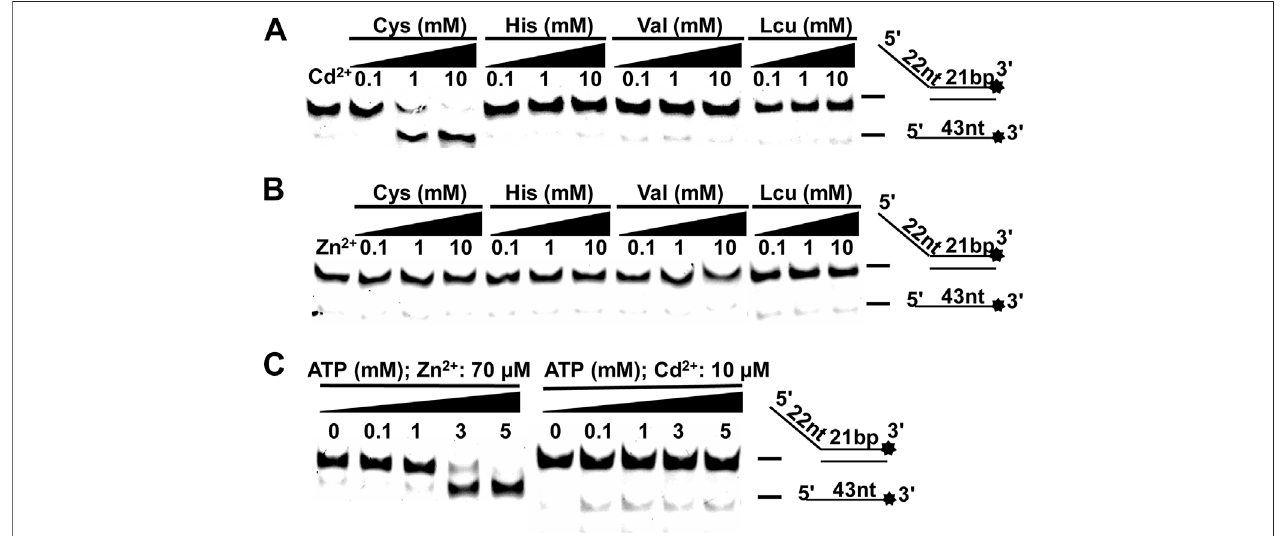
FIGURE6| TheeffectsofaminoacidsandATPontheZn 2+ (Cd 2+ )inhibition. (A – B) CaPif1(25 nM)wasreactedwiththeDNAOhS22D21(10 nM)inthepresenceof theindicatedaminoacids.Lane1:ThecontrolgroupcontainingCd 2+ (10 μ M)orZn 2+ (70 μ M)withoutaminoacid;0.1,1,and10representtheaminoacidconcentration (mM). (C) In the reaction of lower concentrations of Cd 2+ (10 µM) or Zn 2+ (70 µM), the concentration of was increased ATP.